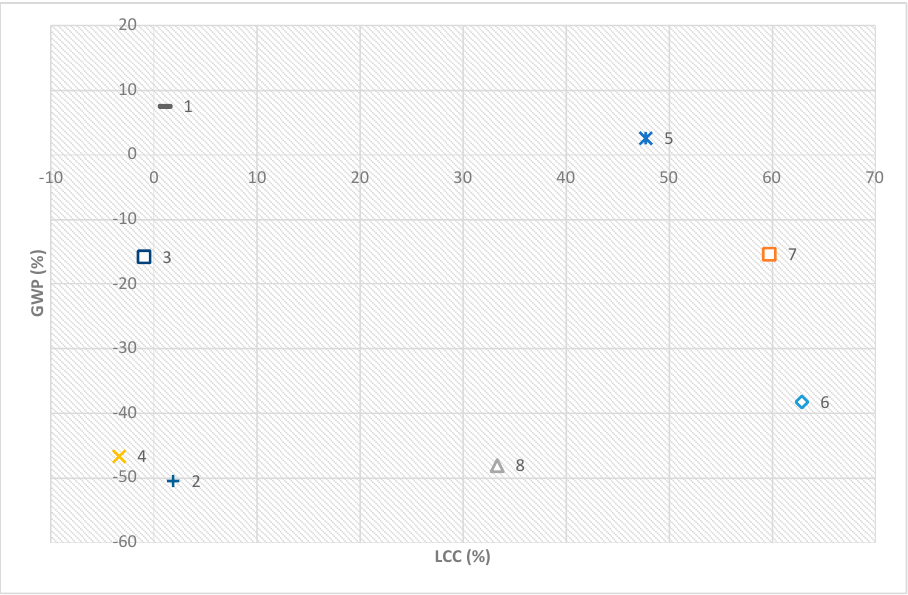
Figure 5. Global warming potential (GWP) against life cycle costs.